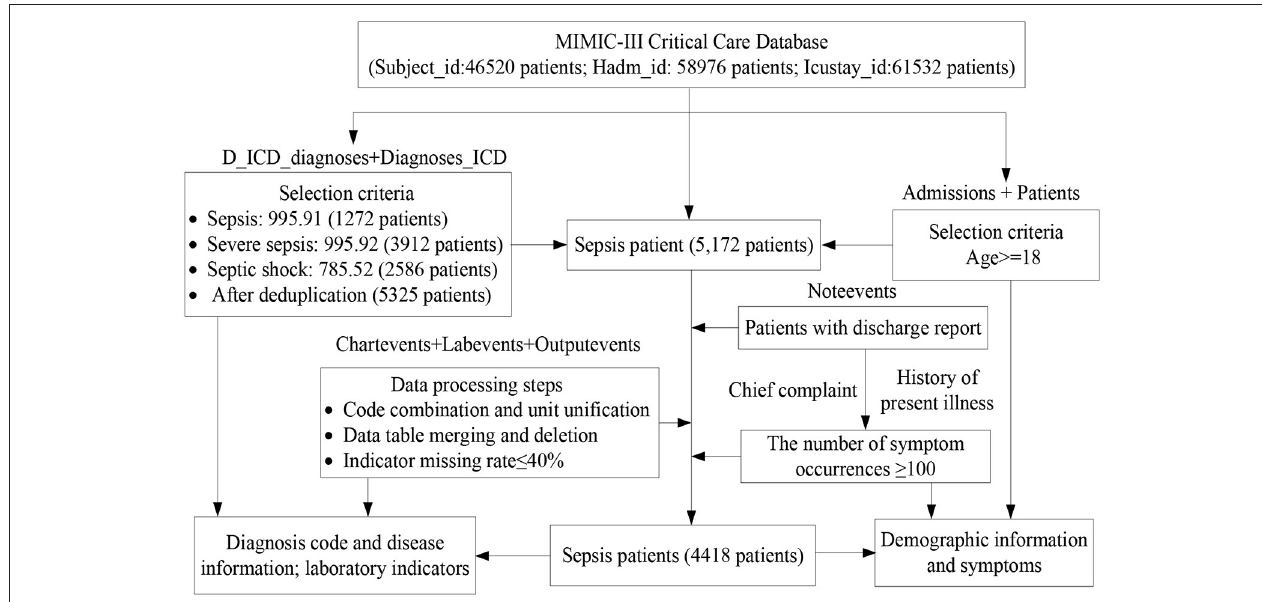
FIGURE 1 | Dataset selection of sepsis patients from the MIMIC-III database.